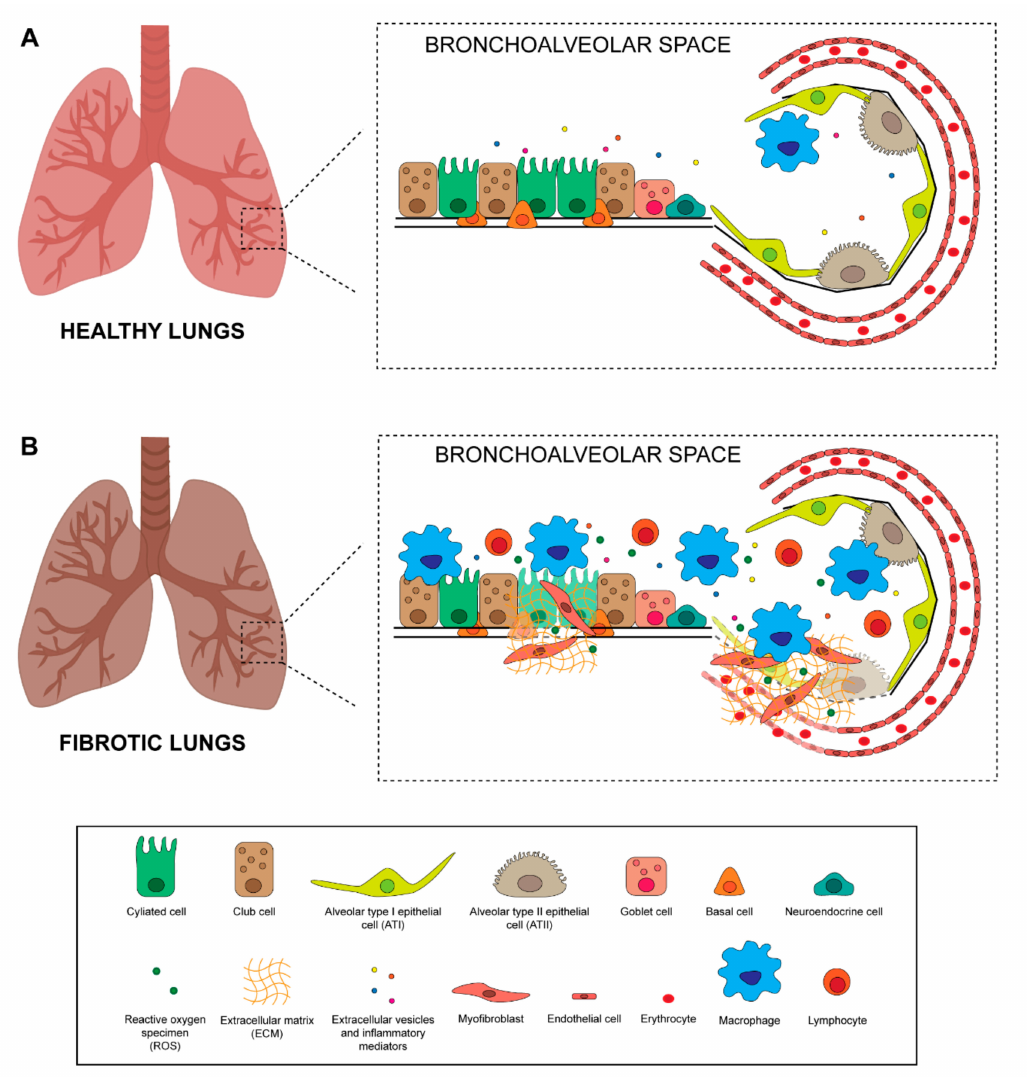
Figure 2. Di ff erences in normal and fibrotic bronchoalveolar tissue. Schematic representation of ( A ) normal bronchoalveolar tissue and ( B ) fibrotic bronchoalveolar tissue